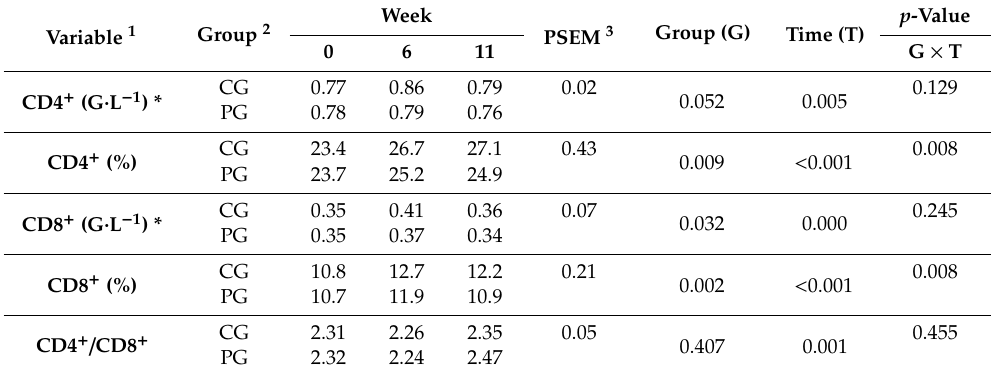
Table 5. E ff ects of a ration change from an indoor based TMR to pasture on cell numbers and proportions of CD4 + and CD8 + cells relative to total mononuclear